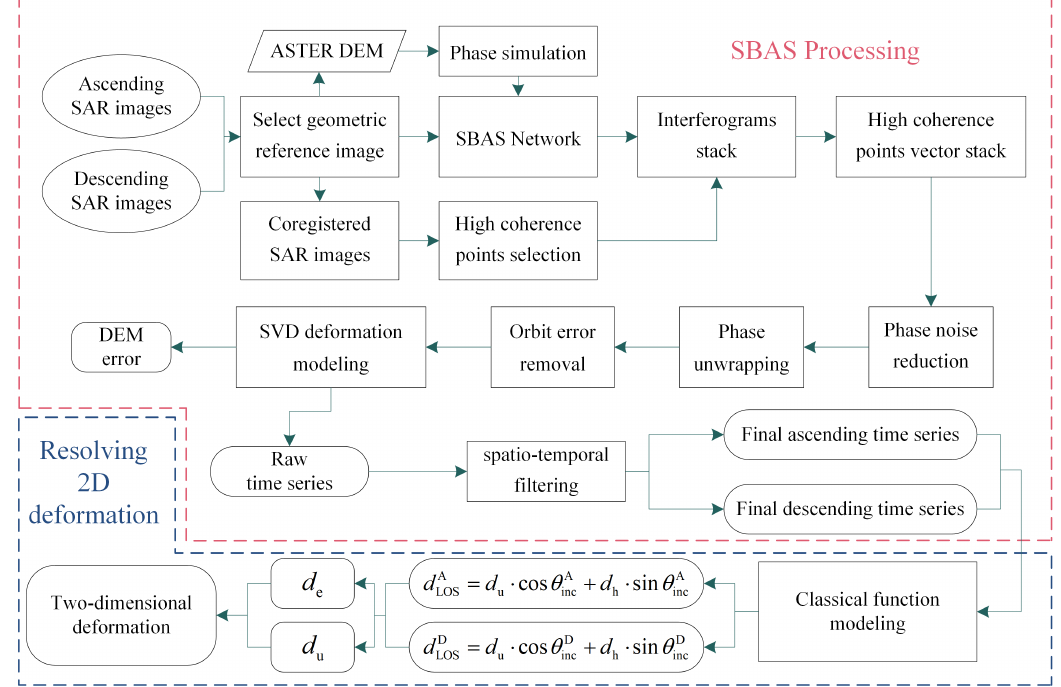
Figure 1. The workflow of the methodology is composed of two parts: SBAS processing and 2D deformation